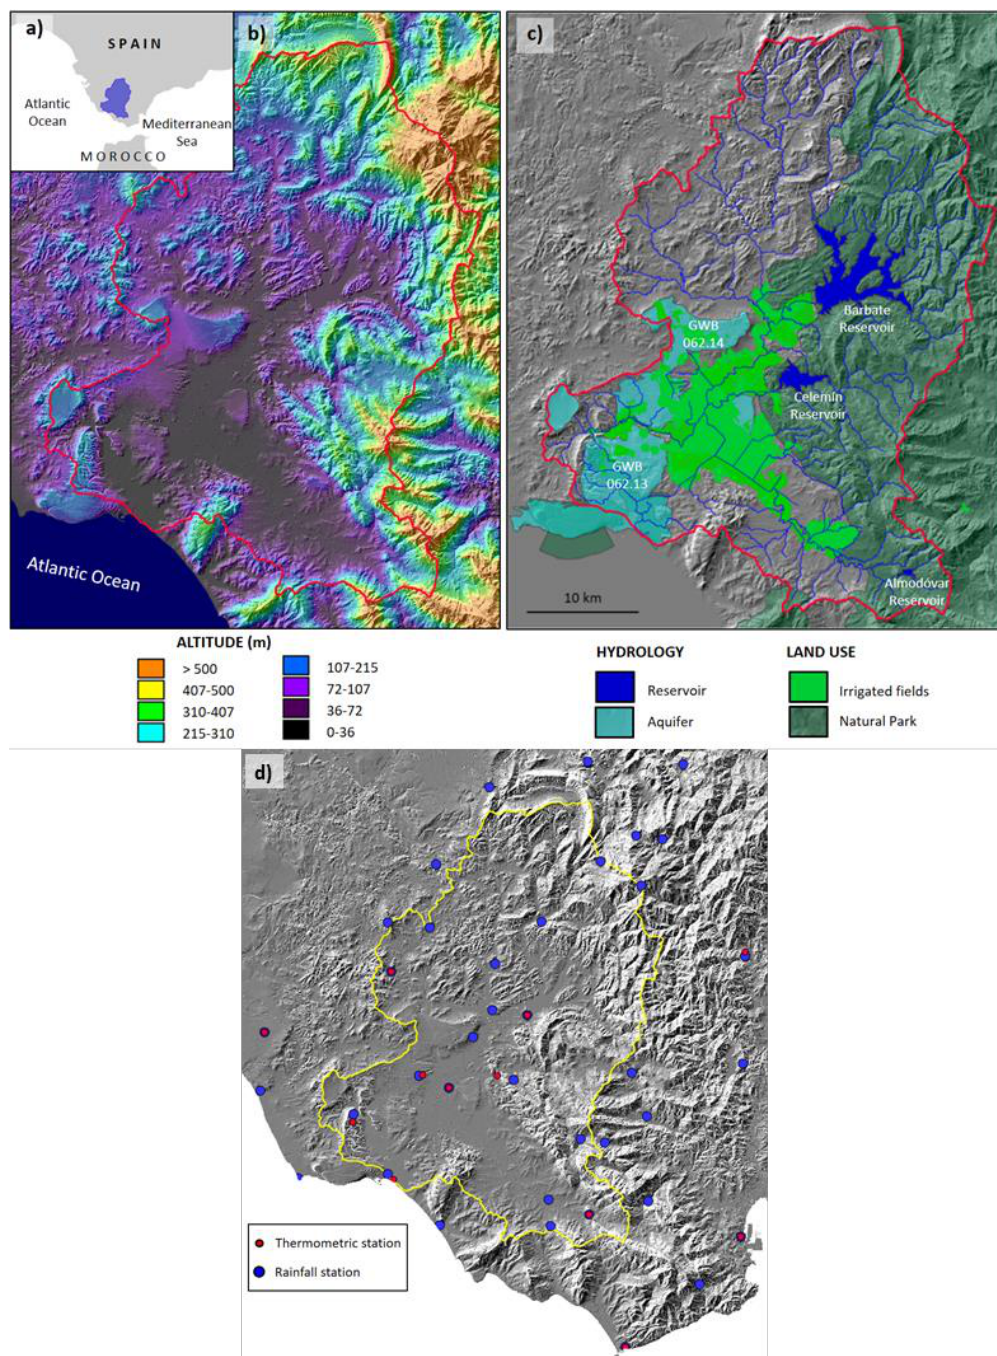
Figure 1. ( a ) Situation map. ( b ) Barbate River Basin orography map. ( c ) Land occupation and hydrological elements. ( d ) Rainfall and thermometric stations map [6].